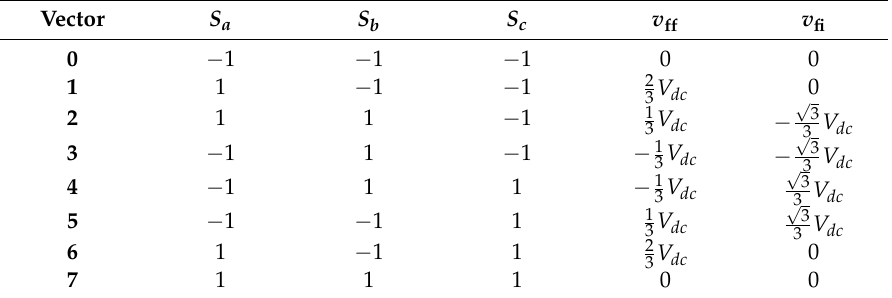
Table 1. Switching states and the corresponding output voltages in αβ